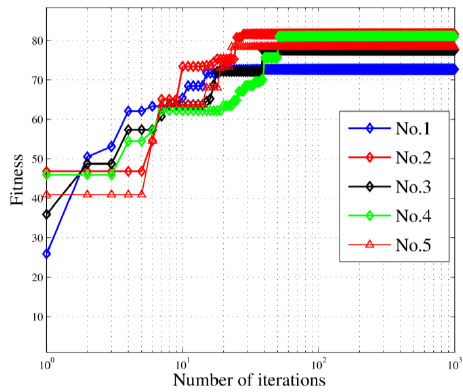
Figure 9. Convergence curves in the Monte-Carlo experiment.